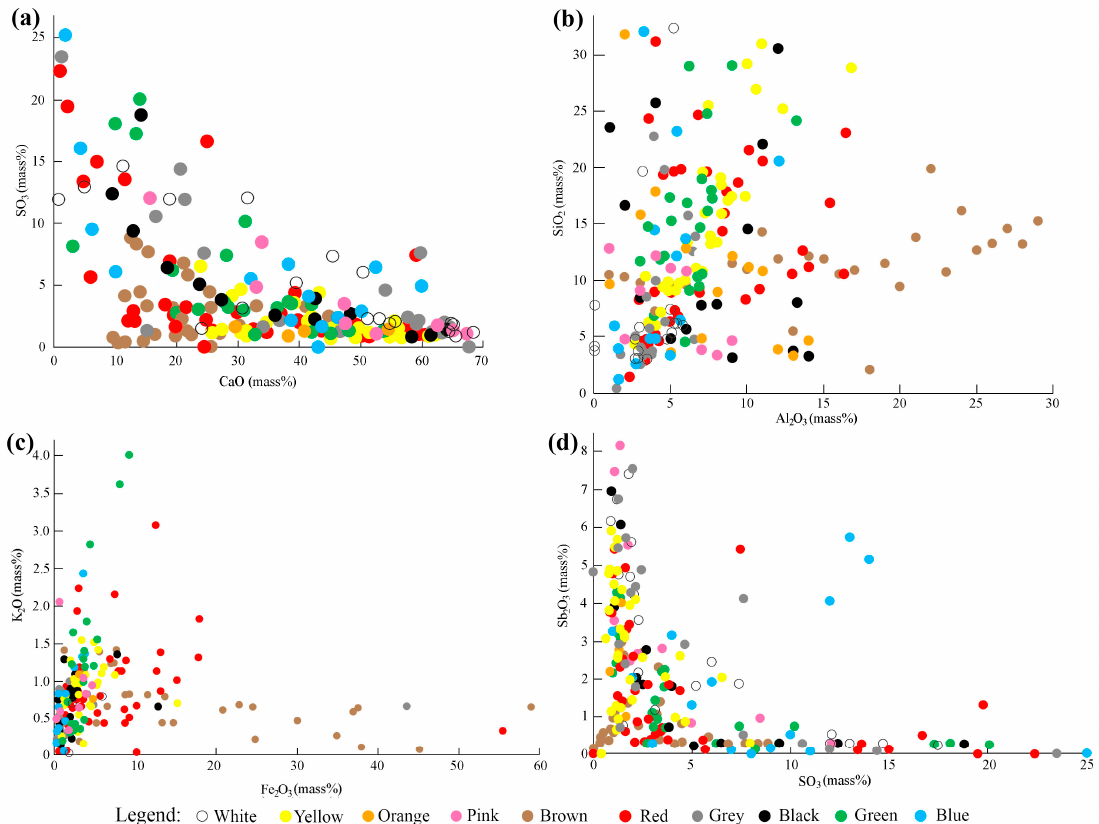
Figure 3. Plot of chemical data for all colors in the discrimination diagrams: ( a ) CaO versus SO 3 ; ( b ) Al 2 O 3 versus SiO 2 ; ( c ) Fe 2 O 3 versus K 2 O; and ( d ) SO 3 versus Sb 2 O 3 .